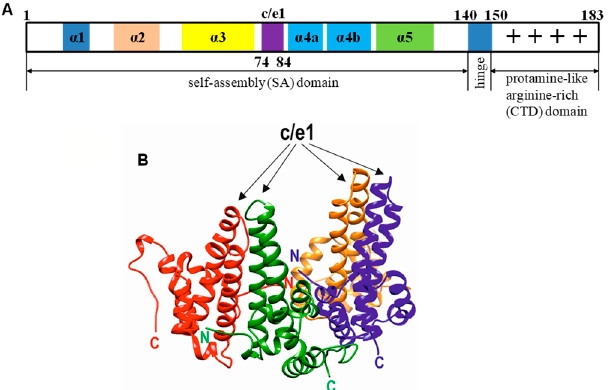
Figure 1. The structure of the HBc protein. ( A ) HBV HBc monomer represented by 183 aa-long HBc, genotype D1, subtype ayw2 (GenBank accession number XO2496) [47]. ( B ) The structure of two HBc dimers. Monomer chains A, B, C, and D are marked in red, green, blue, and orange, respectively. Surface-exposed loops with c and e1 epitopes are shown with arrows, N- and C- termini are labeled with N and C letters, respectively. Data were downloaded from the VIPERdb v3.0